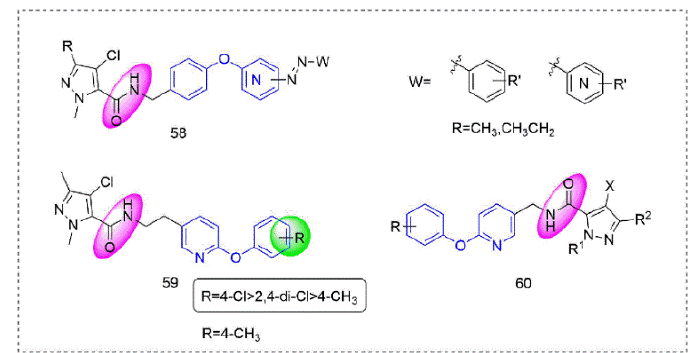
Figure 13. Complex I inhibitors (Pyrazole-5-carboxamide) containing phenoxypyridine.